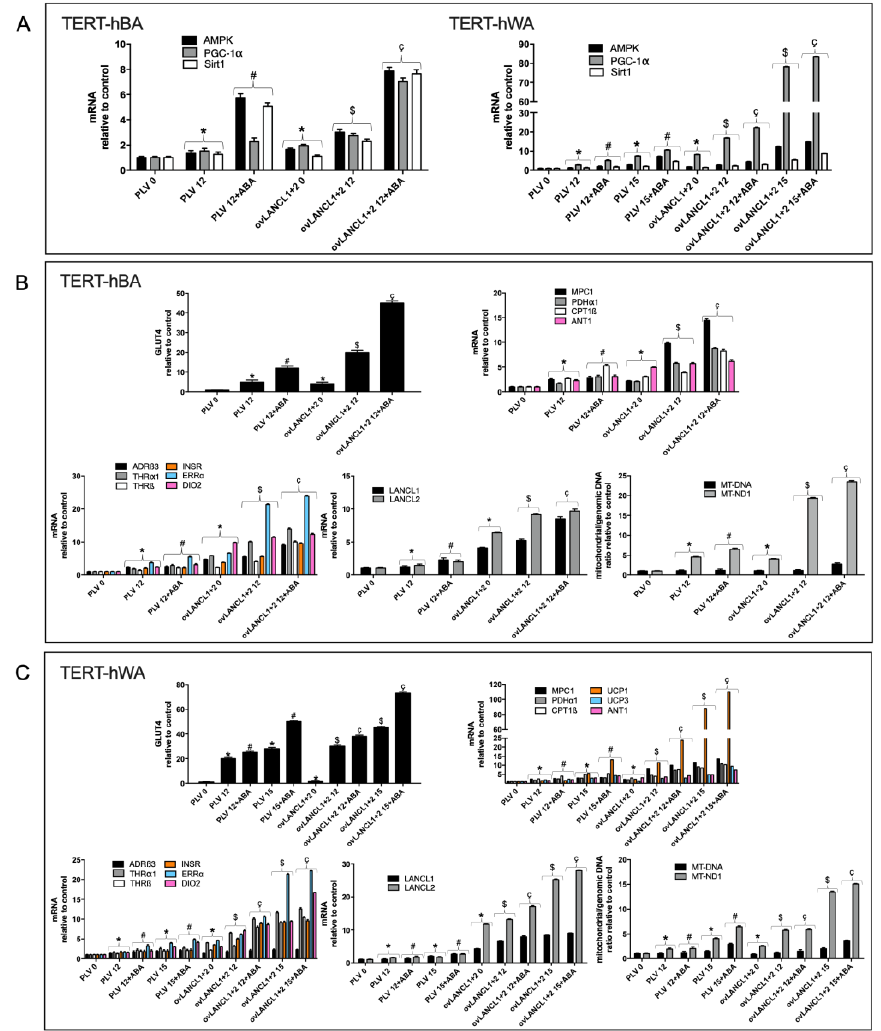
Figure 4. Transcriptional effects of the overexpression of LANCL1/2 on differentiated brown and white adipocytes. Human brown (TERT-hBA) or white (TERT-hWA) preadipocytes overexpressing LANCL1 and LANCL2 (ovLANCL1+2), or control cells infected with the empty vector (PLV), were differentiated to white or brown adipocytes in the absence or in the presence of 100 nM ABA: at days 0, 12 and 15 of culture, mRNA levels of the indicated genes were evaluated by qPCR. ( A ) analysis of the AMPK/PGC-1 α /Sirt1 signaling axis in TERT-hBA (left panel) and TERT-hWA (right panel). ( B ) TERT-hBA; upper left panel, GLUT4 mRNA; upper right panel, carnitine palmitoyl transferase 1 β (CPT1 β ), mitochondrial pyruvate carrier 1 (MPC1), pyruvate dehydrogenase subunit α 1 (PDH α 1) and adenine nucleotide translocase 1 (ANT1) mRNAs; lower left panel, adrenergic receptor β -3 (ADR β 3), thyroid receptor α -1 (THR α 1), thyroid receptor β (THR β ), insulin receptor (INSR), estrogen related receptor α (ERR α ) and deiodinase 2 (DIO2) mRNAs; lower central panel, LANCL1/2 mRNAs; lower right panel, mitochondrial/genomic DNA ratio (MT-DNA and MT-ND1). * p < 0.02 relative to undifferentiated untreated control, # p < 0.006 relative to differentiated control, $ p < 0.003 relative